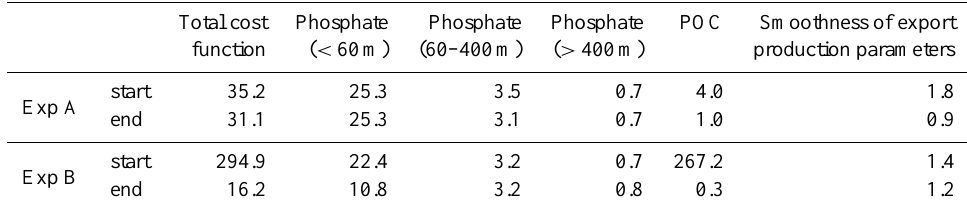
Table 3. Values of total cost function and individual terms (units of 10 7 ) for Exp A and Exp B. Total cost Phosphate Phosphate Phosphate POC Smoothness of export function (60–400m) ( > 400m) production